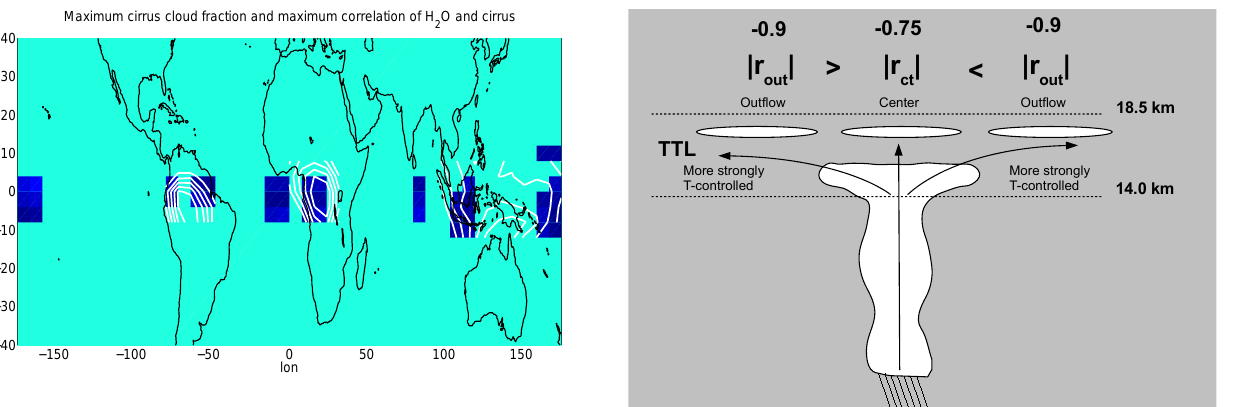
Fig. 6. Qualitative picture of the regions with maximum cirrus cloud fraction (contours) and maximum anticorrelation of water vapor and cirrus cloud fraction (dark blue rectangles). Data is averaged over the 5 yr period. The correlation is highest off the center of max- imum cirrus occurrence. Over Indonesia the regions of maximum correlation are quite symmetrical around the center of maximum cirrus fraction. We suggest that water vapor is closer to saturation in the outflow regions and a small change in temperature can pro- duce a phase change.